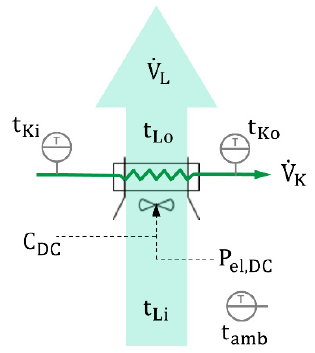
can be considered (e.g., for a control unit). Assuming a quadratic development of the air-side pressure